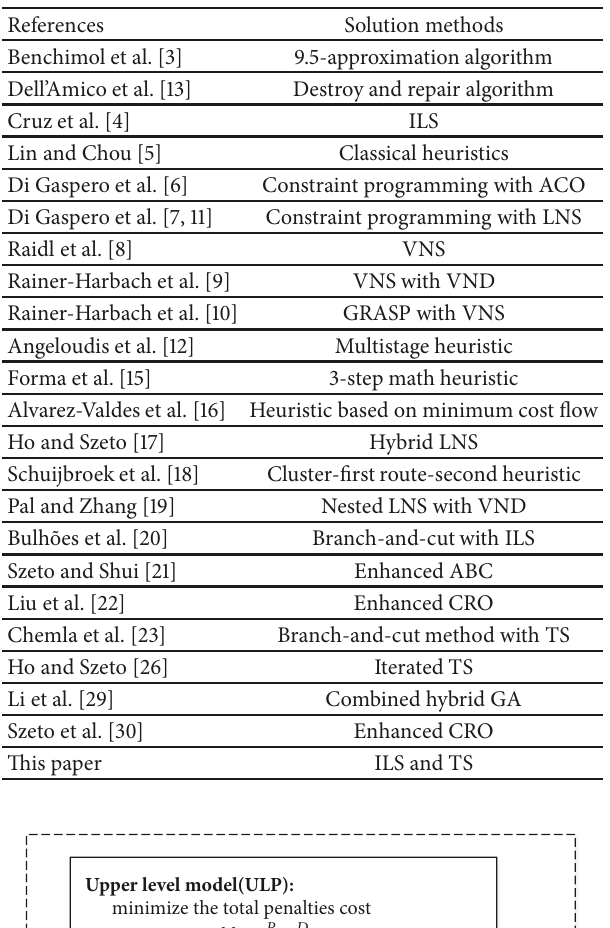
Table 2: Summary of inexact solution methods for the static BRP in the literature.